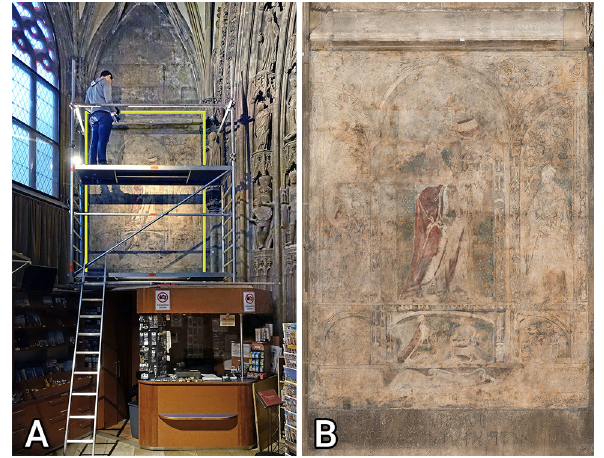
Figure 1 . (A) Photographing from two small scaffolding boards (photo by R. Burszan, adapted by G. Verhoeven). (B) The entire mural painting, whose extent is indicated in yellow on